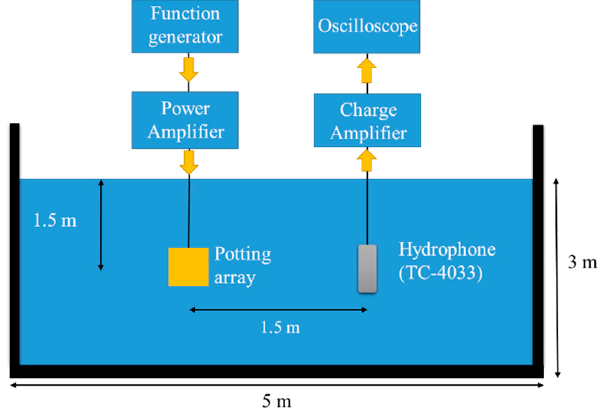
Figure 11. Experimental setup for underwater TVR spectrum measurement.